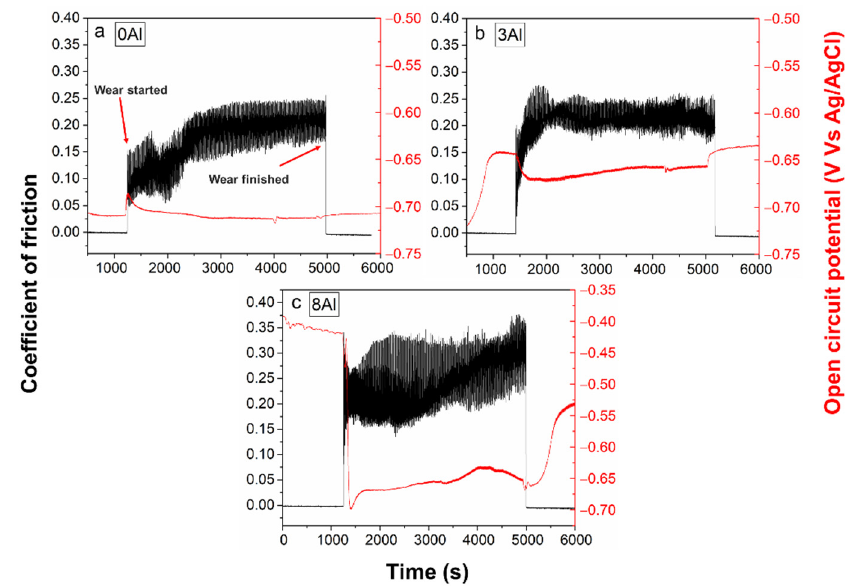
Figure 8. Evolution of the coefficient of friction and open circuit potential for the ( a ) 0Al; ( b ) 3Al; ( c ) 8Al alloys under total wear test, T.